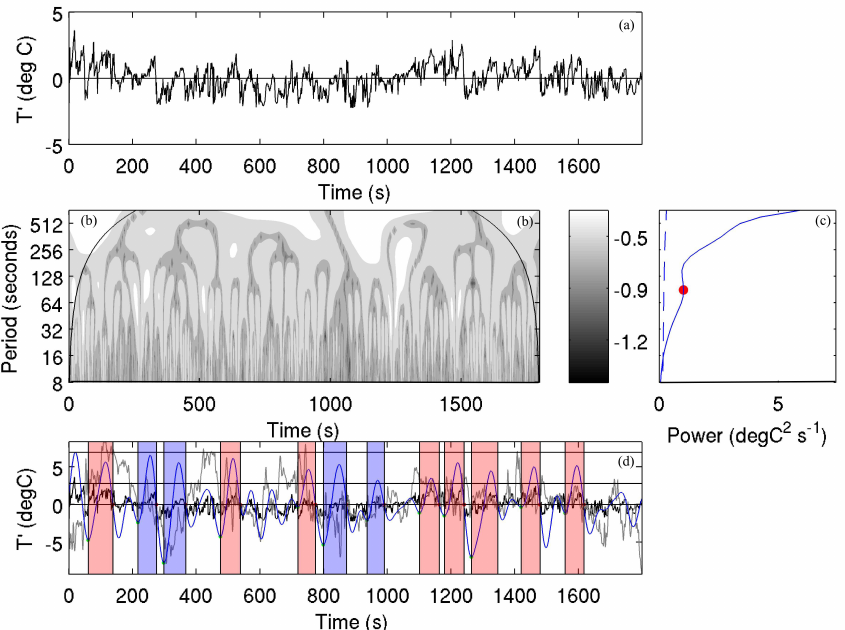
Fig. B1. Sample wavelet analysis for a single 30-min period (14:30LT on 28 July 2009) based on the Barthlott et al. (2007) detection method. (a) Temperature perturbation from the mean (K), (b) Wavelet period versus time, (c) Global wavelet spectrum, with the peak power (red dot), which selects the power for the wavelet spectrum for this half hour, and (d) plot of temperature perturbation ( T 0 ; black line), vertical wind perturbation ( w 0 ; gray line), wavelet (blue line), and detected burst periods ( w 0 positive; red shaded regions) and sweep periods ( w 0 negative; blue shaded regions).